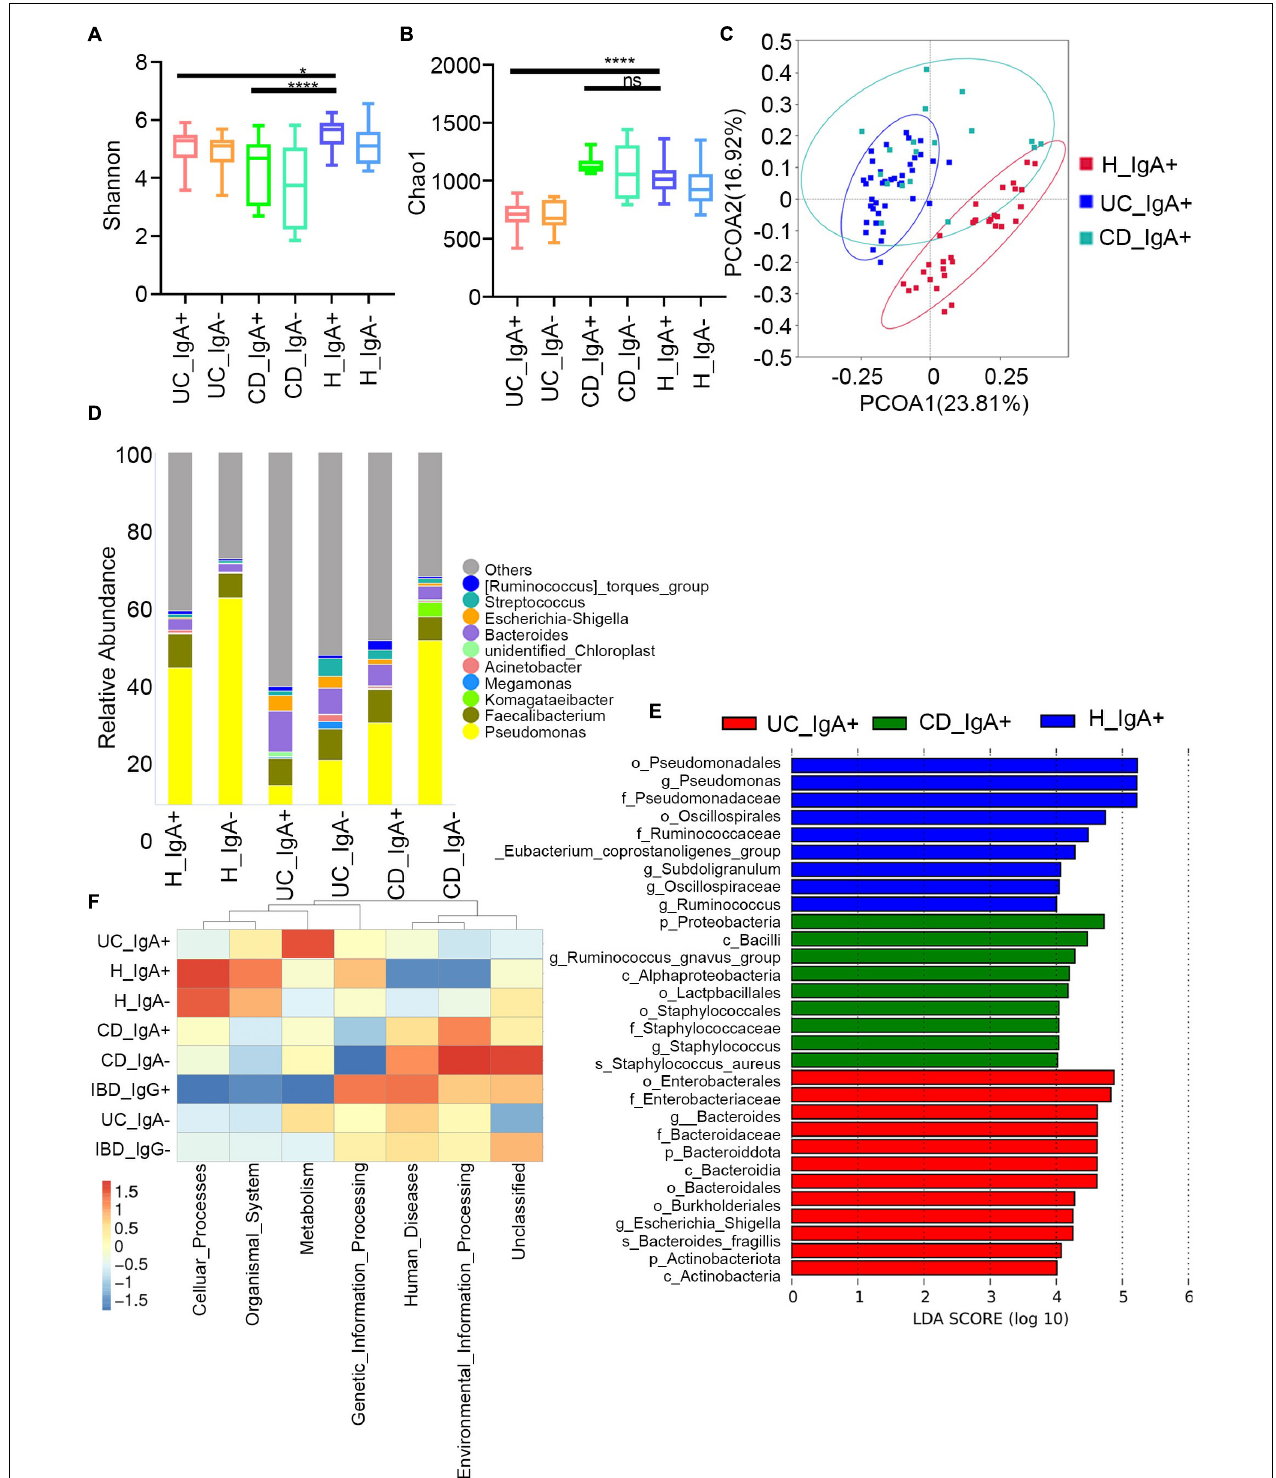
FIGURE 3 | Characteristics of IgA -bound commensal bacteria. (A) Shannon index. (B) Chao1 index. (C) PcoA index. (D) Heatmap analysis of the difference in genera of the gut microbiota in each group of IgA + / − by Metastat. (E) Stacked bar plot of the genus structure in each group. (F) Heatmap analysis of the function prediction among different